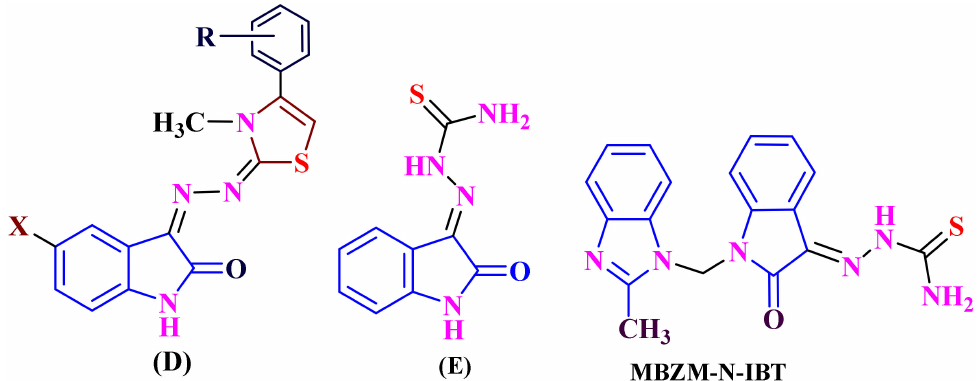
Figure 2. Anti-viral drugs: isatin-thiazoline hybrids ( D ), isatin-hydrazine-1-carbothioamide ( E ), isatin- β -thiosemicarbazone hybrids- imidazoles (MBZM- N-IBT) from isatin